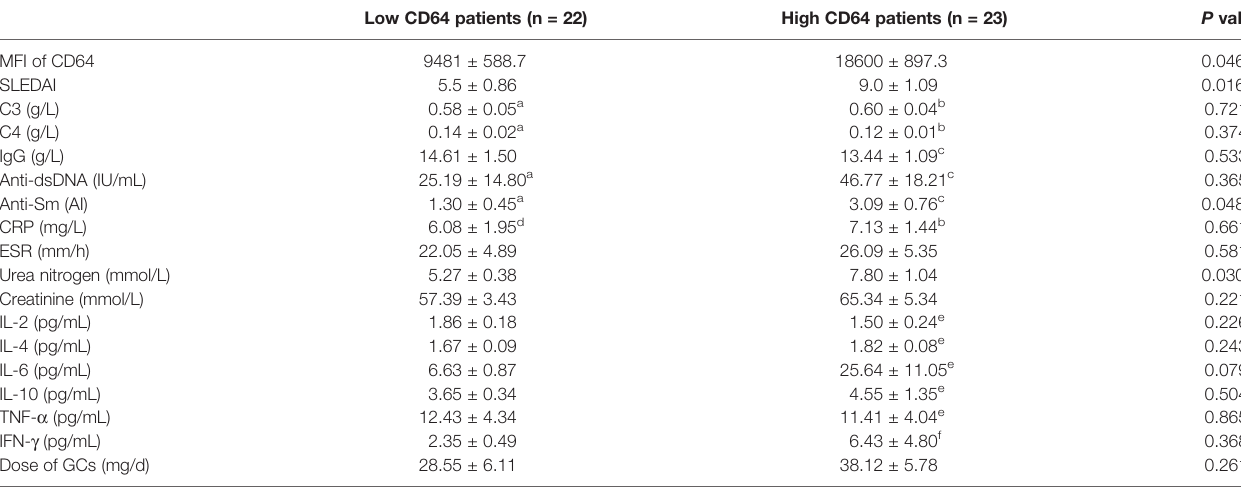
TABLE 2 | Comparisons of CD64 expression (MFI) with laboratory measurements and dose of glucocorticoids in